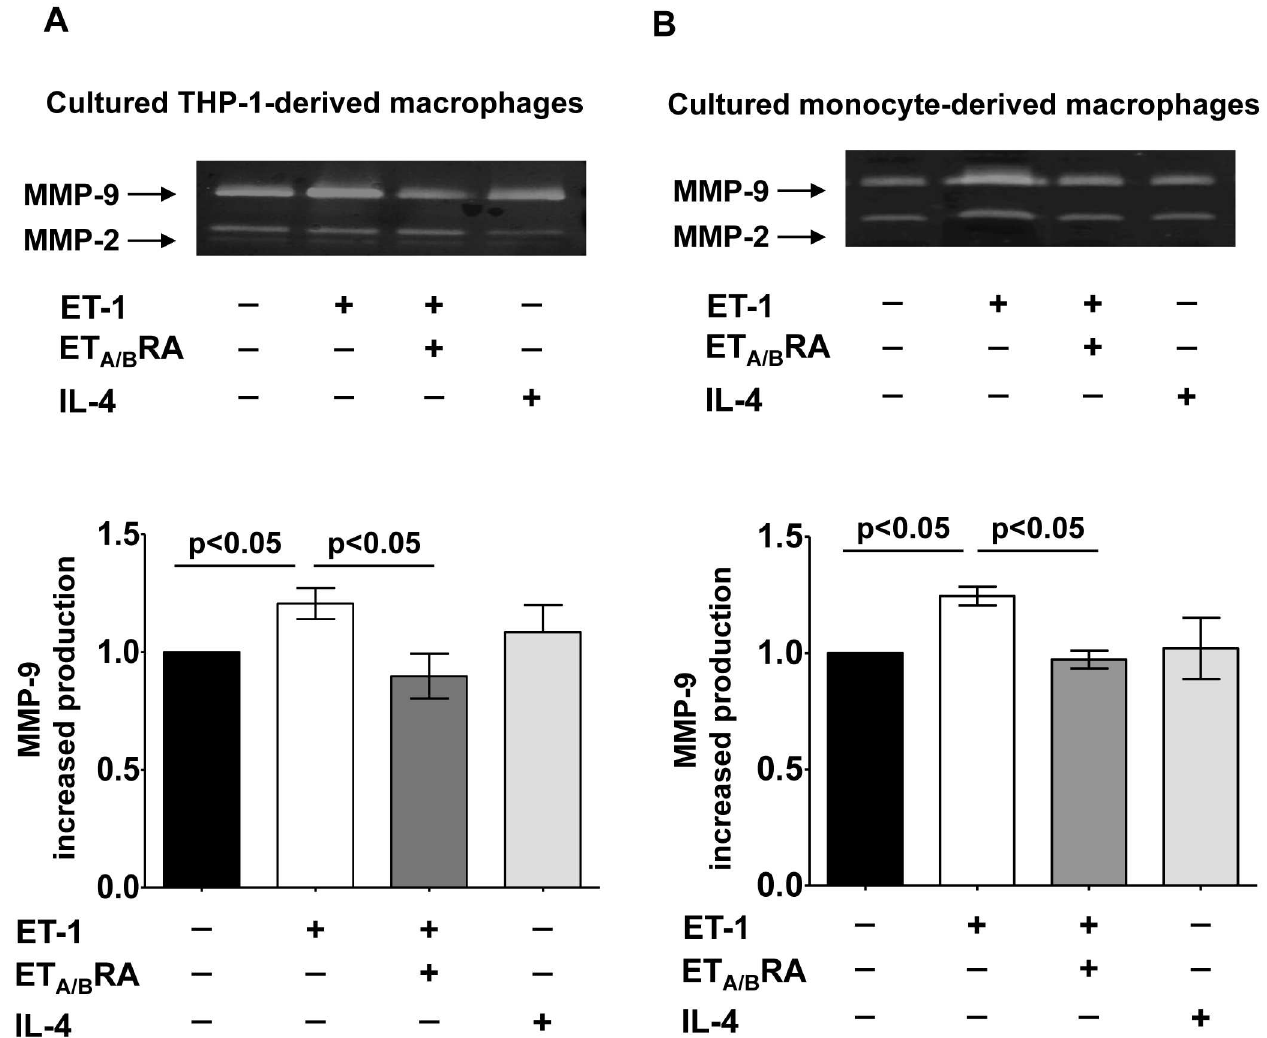
Fig 7. Evaluation of pro-fibrotic MMP-9 production in cultured macrophages. Evaluation by gel zymography of MMP-9 productionand related densitometric analysisin cultured M0-macrophagesand humanmonocyte-derived macrophages. (A) CulturedM0 macrophageswere treated for 72 hours with ET-1 (100nM) and IL-4 (10ng/mL) alone, or pre-treatedwith ET A/B RA (bosentan, 10 -5 M) for 1 hour before the stimulation with ET-1. CulturedM0 macrophages maintained for 72 hours in RPMI at 5% of FBS were used as controls (M0-controls). (B) Culturedhuman monocyte-derived macrophages treated for 6 days with ET-1 (100nM) and IL-4 (10ng/mL) alone, or pre-treatedwith ET A/B RA (10 -5 M) for 1 hour before the stimulationwith ET-1. Cultured humanmonocyte-derivedmacrophages maintained for 6 days in RPMI at 10% of FBS were used as untreatedcells. Gel zymography was performed on six independent in vitro experiments and the data of MMP-9 production are shown as mean ± SD.